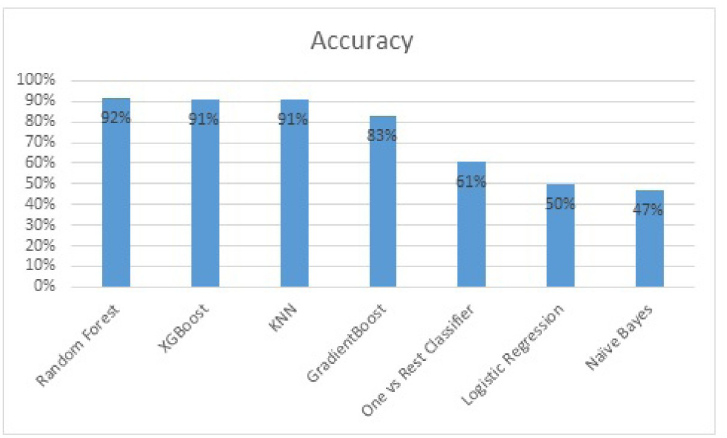
Fig 7. Cross-validated scores of multiple algorithms.